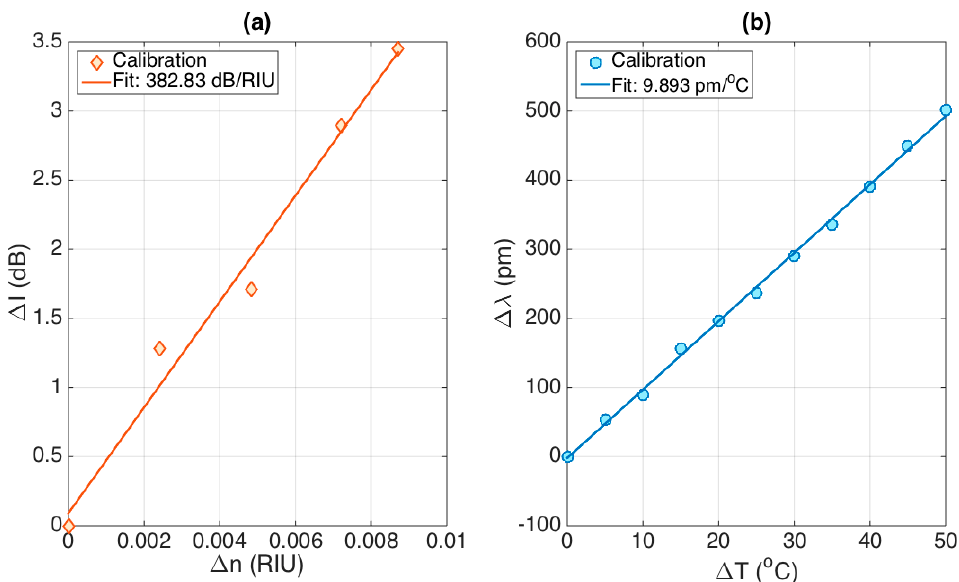
Figure 7. Evaluation of the dual stCFBG sensitivity to RI and temperature. ( a ) RI response, evaluating Δ I as a function of Δ n ; the sensitivity Δ I/ Δ n is estimated as 382.83 dB/RIU, with R 2 = 0.9822. ( b ) Temperature response, evaluating Δλ as a function of Δ T; the sensitivity Δλ / Δ T is estimated as 9.893 pm/°C, with R 2 = 0.9982.